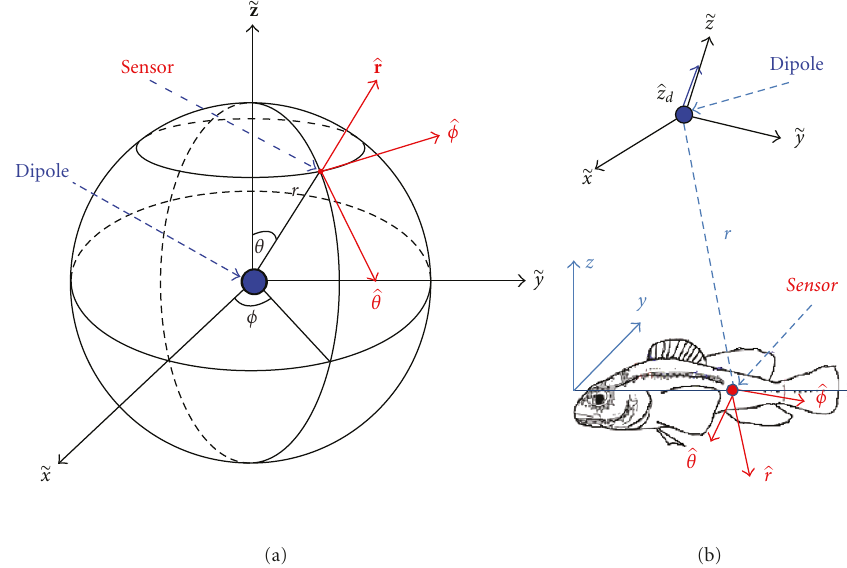
Figure 2: Translating the flow velocity vector at a sensor location impact by a dipole in di ff erent coordinate systems. (a) The flow velocity in the dipole’s spherical coordinates with ( r , θ , φ ) defining the location of a sensor with repect to the dipole and ( (cid:4) r , (cid:4) θ , (cid:4) φ ) defining the unit vectors of the dipole’s spherical coordinates at the sensor’s position (modified from [16]). (b) Flow velocity is computed in the lateral line’s Cartesian coordinates (modified from